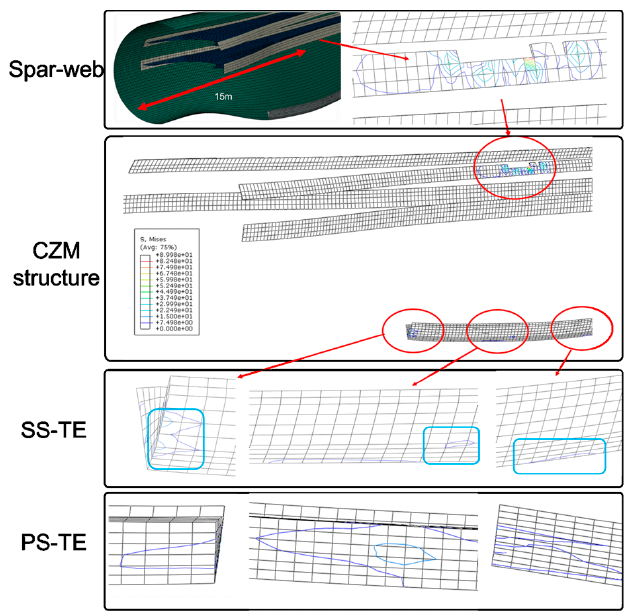
Figure 18. Crack growth shape depending on the wind blade scale: 86% load scale. Finally, the analysis was performed up to 200% of the load scale, and a progressive failure was observed in the direction of the root from the initial failure location of 15 m, as shown in Figure 19. In the TE area, a progressive failure occurred at 160% of the load scale after the initial failure, which was at 140% of the load scale.